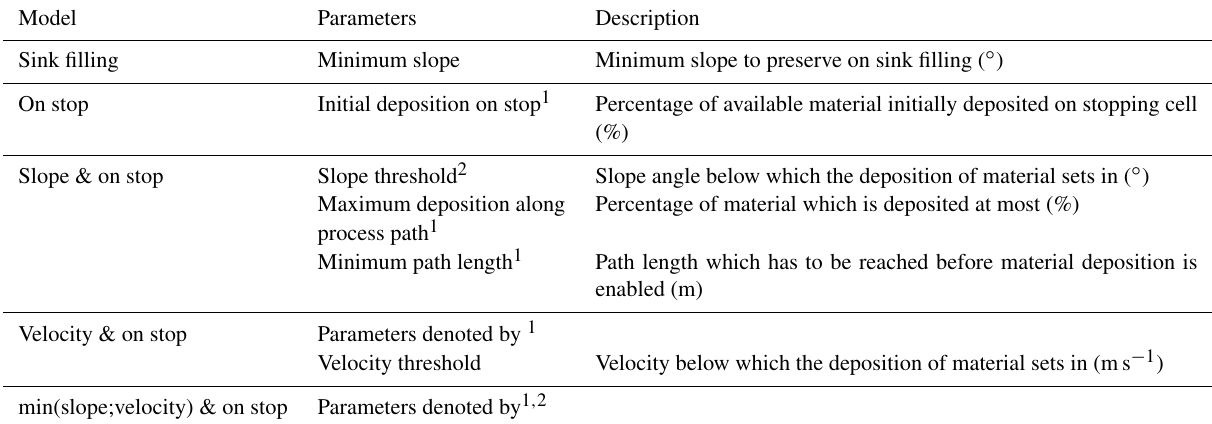
Table A3. The deposition parameters of the GPP model.